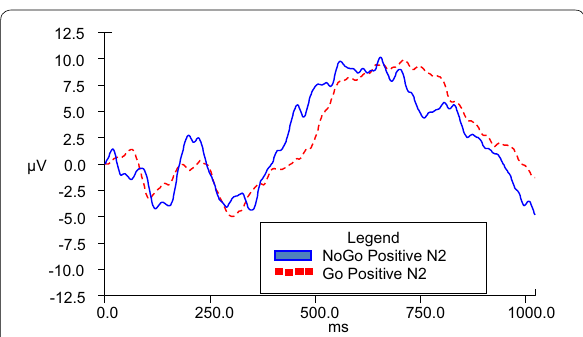
Fig. 5 Go and NoGo N2 ERP grand averages for 280-ms positive condition at electrode FZ